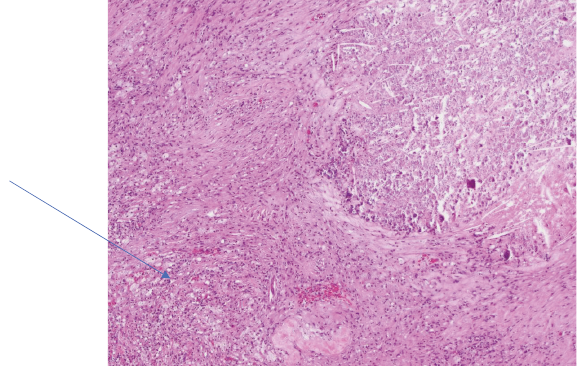
Figure 7: Necrotic tumor with calcifications surrounded by foamy histiocyte